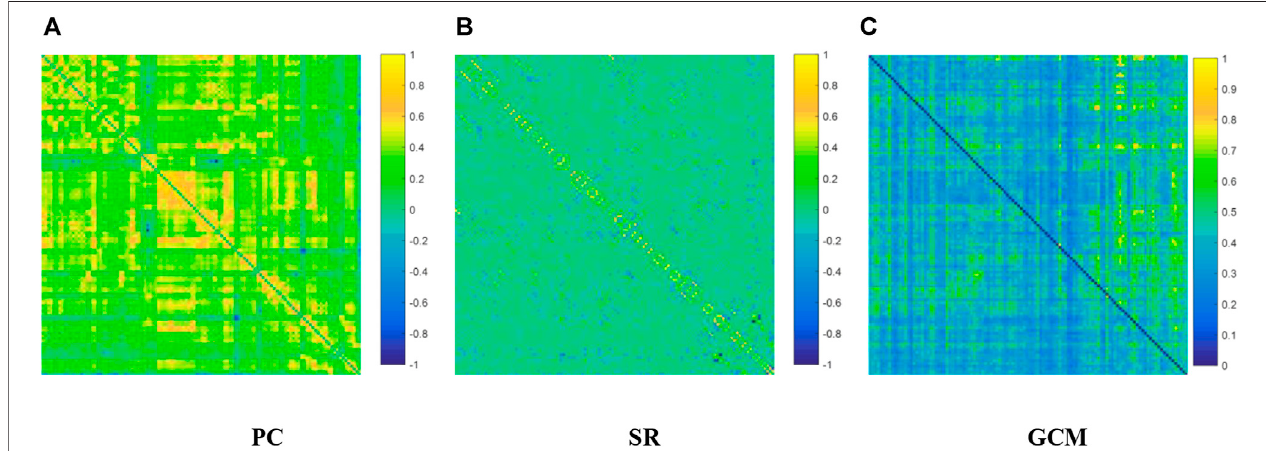
FIGURE 3 | The connection networks obtained by the (A) PC, (B) SR and (C) GCM methods.